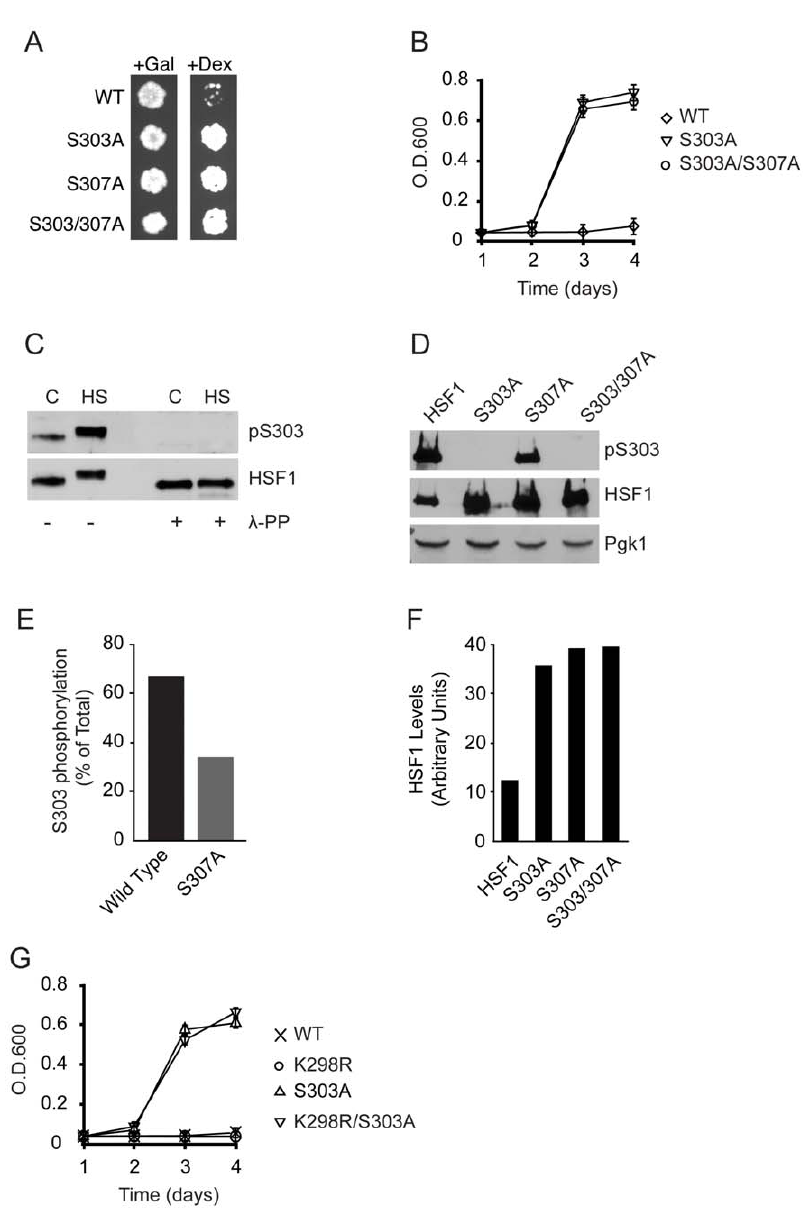
Figure 1. S303 phosphorylation represses HSF1 activity in yeast. ( A ) PS145 yeast strains expressing wild-type HSF1 (WT) or the S303A, S307A or S303/307A mutants were plated on either galactose or dextrose supplemented medium. ( B ) PS145 expressing either wild-type HSF1 or the S303A or S303/307A mutants were grown in dextrose containing medium for 4 d. Growth was monitored by measuring O.D. 600 . ( C ) HeLa cells were grown at 37 u C (C) or heat shocked for 2 h at 42 u C (HS). Total protein extracts were treated with lambda protein phosphatase and analyzed for phospho-S303 (pS303) and total HSF1 levels by immunoblotting. ( D ) PS145 was transformed with a plasmid expressing wild-type HSF1 (WT) or mutant alleles of HSF1 and grown on galactose containing medium. Total protein extracts were analyzed for pS303, HSF1 and Pgk1 by immunoblotting. ( E ) Levels